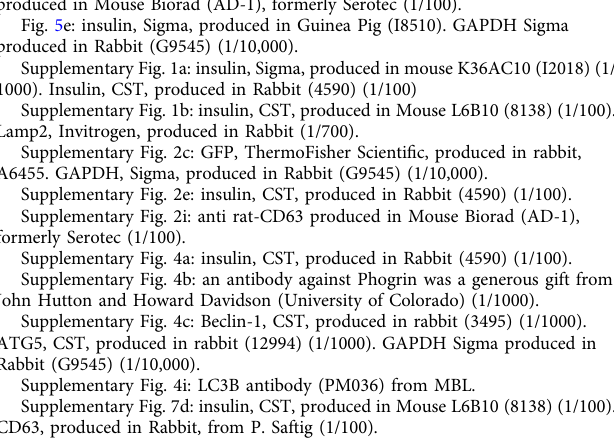
Fig. 3e: insulin, CST, produced in rabbit 4590 (1/100). p62, Progen, produced in guinea pig (GP62-C) (1/100). Fig. 3f: p62, progen, produced in guinea pig (GP62-C) (1/1000). GAPDH Sigma produced in rabbit (G9545) (1/10,000). Fig. 4a: anti-phospho-PRKD1 (pSer910), Sigma, produced in rabbit (SAB4300075) (1/1000). Tubulin, Sigma, produced in mouse (T9026) (1/10,000). Insulin, Sigma, produced in guinea Pig (I8510). Fig. 4c: PKD/PKC μ Antibody, CST, rabbit (2052) (1/1000). Tubulin, Sigma, produced in mouse (T9026) (1/10,000). Fig. 4f: anti-phospho-PRKD1 (pSer910), Sigma, produced in rabbit (SAB4300075) (1/1000). PKD/PKC μ Antibody, CST, rabbit (2052) (1/1000). GAPDH Sigma produced in Rabbit (G9545) (1/10,000). Fig. 4g, h: insulin, Sigma, produced in Guinea Pig (I8510). GAPDH Sigma produced in Rabbit (G9545) (1/10,000). Fig. 5a: insulin, CST, produced in Rabbit (4590) (1/100). Fig. 5b: insulin, Sigma, produced in mouse K36AC10 (I2018) (1/1000). Fig. 5c: C-peptide I, produced in mouse, Biorad, Formerly Serotec (MCA2857) (1/1000). GAPDH Sigma produced in Rabbit (G9545) (1/10,000). Fig. 5d: insulin, CST, produced in Rabbit (4590) (1/100). Anti rat-CD63 produced in Mouse Biorad (AD-1), formerly Serotec (1/100). Fig. 5e: insulin, Sigma, produced in Guinea Pig (I8510). GAPDH Sigma produced in Rabbit (G9545) (1/10,000). Supplementary Fig. 1a: insulin, Sigma, produced in mouse K36AC10 (I2018) (1/ 1000). Insulin, CST, produced in Rabbit (4590) (1/100) Supplementary Fig. 1b: insulin, CST, produced in Mouse L6B10 (8138) (1/100). Lamp2, Invitrogen, produced in Rabbit (1/700). Supplementary Fig. 2c: GFP, ThermoFisher Scienti fi c, produced in rabbit, A6455. GAPDH, Sigma, produced in Rabbit (G9545) (1/10,000). Supplementary Fig. 2e: insulin, CST, produced in Rabbit (4590) (1/100). Supplementary Fig. 2i: anti rat-CD63 produced in Mouse Biorad (AD-1), formerly Serotec (1/100). Supplementary Fig. 4a: insulin, CST, produced in Rabbit (4590) (1/100). Supplementary Fig. 4b: an antibody against Phogrin was a generous gift from John Hutton and Howard Davidson (University of Colorado) (1/1000). Supplementary Fig. 4c: Beclin-1, CST, produced in rabbit (3495) (1/1000). ATG5, CST, produced in rabbit (12994) (1/1000). GAPDH Sigma produced in Rabbit (G9545) (1/10,000). Supplementary Fig. 4i: LC3B antibody (PM036) from MBL. Supplementary Fig. 7d: insulin, CST, produced in Mouse L6B10 (8138) (1/100). CD63, produced in Rabbit, from P. Saftig (1/100). Mice . BTBR ob/ + 42 (BTBR background) mice were obtained from Charles River and were maintained by heterozygous breeding to generate + / + and ob/ob